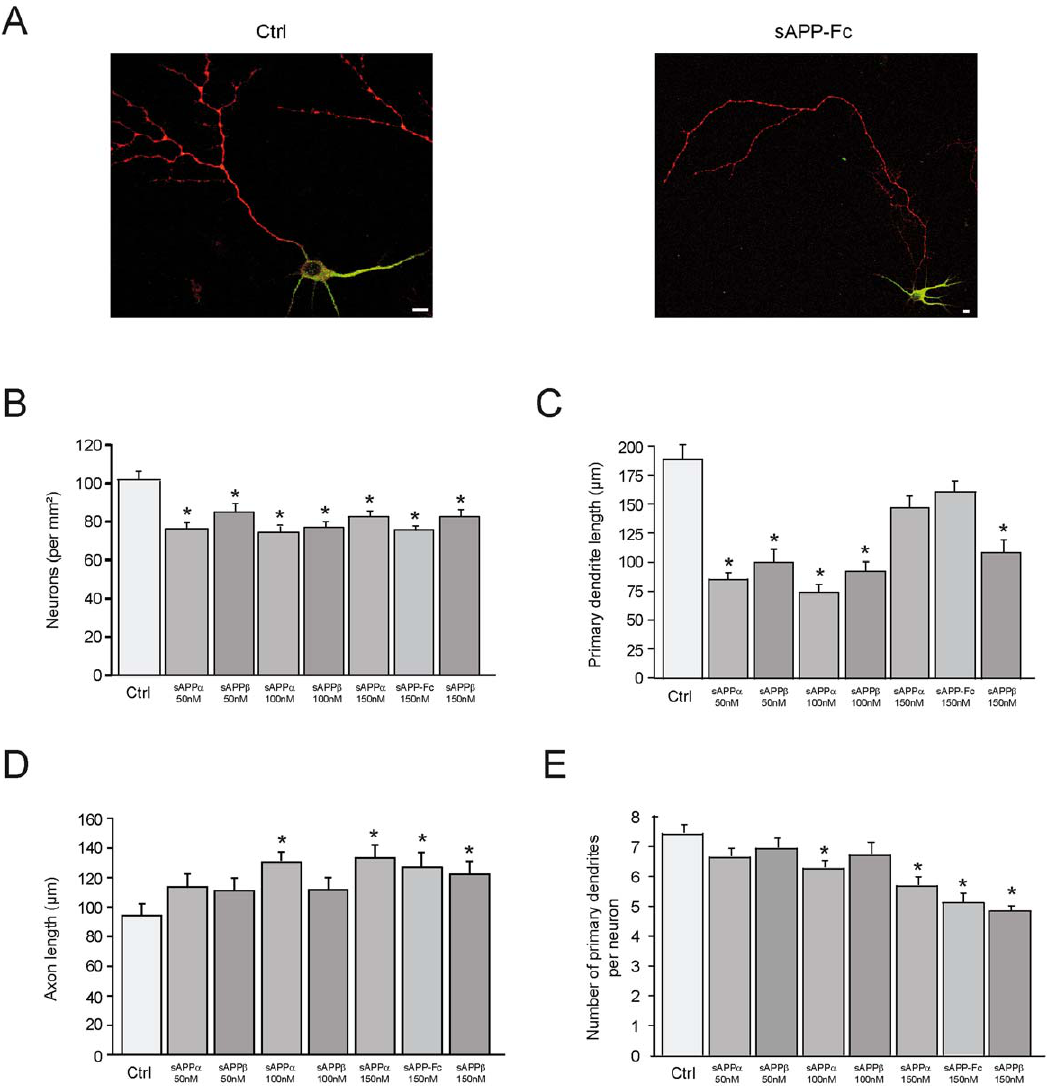
Figure 1. Changes in cell adhesion and in neuronal morphology induced by sAPP a , sAPP b and sAPP-Fc added to neurons after 1 DIV. ( A ) 5DIV neurons were immunostained for MAP2 (green) and Tau (red). Representative confocal merged images show that the longest neurite is stained for Tau, an axonal marker, in control (Ctrl) neurons or after addition of sAPP-Fc to 1DIV neurons. Scale Bar: 10 m m. ( B ) Adhesion is significantly reduced after sAPP a or sAPP b (50 to 150 nM). sAPP a and sAPP b were added to primary neurons after 1DIV and adhesion assays were performed 24 hours later. (50 nM: control (Ctrl) vs sAPP a : p , 0.001, control vs sAPP b : p , 0.04; 100 nM: control vs sAPP a : p , 0.0001, control vs sAPP b : p , 0.0005; 150 nM: control vs sAPP a : p , 0.003, control vs sAPP-Fc: p , 0.005, control vs sAPP b : p , 0.01). ( C–E ) Morphometric analysis 96 hours after the addition of sAPPs (50 to 150 nM) to 1DIV primary neurons. (C) At 50 and 100 nM sAPP a and sAPP b induce a significant decrease of primary dendrite length while at 150 nM, the decrease in primary dendrite length is still significant for sAPP b only (50 nM: control (Ctrl) vs sAPP a : p , 0.0001, control vs sAPP b : p , 0.0001; 100 nM: control vs sAPP a : p , 0.0001, control vs sAPP b : p , 0.0001; 150nM: control vs sAPP a : NS, control vs sAPP-Fc: NS, sAPP a vs sAPP-Fc: NS, control vs sAPP b : p , 0.0001). (D) At 150 nM sAPP a , sAPP-Fc and sAPP b induce an increase of axon elongation (150 nM: control (Ctrl) vs sAPP a